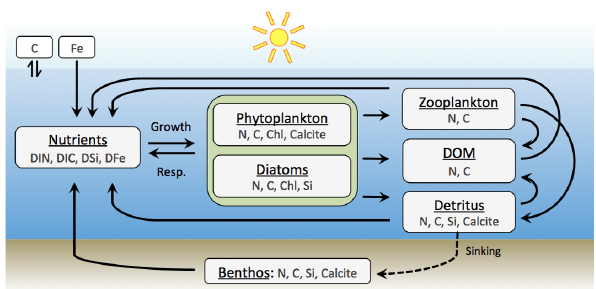
Figure 2. The pathways in the biogeochemical model